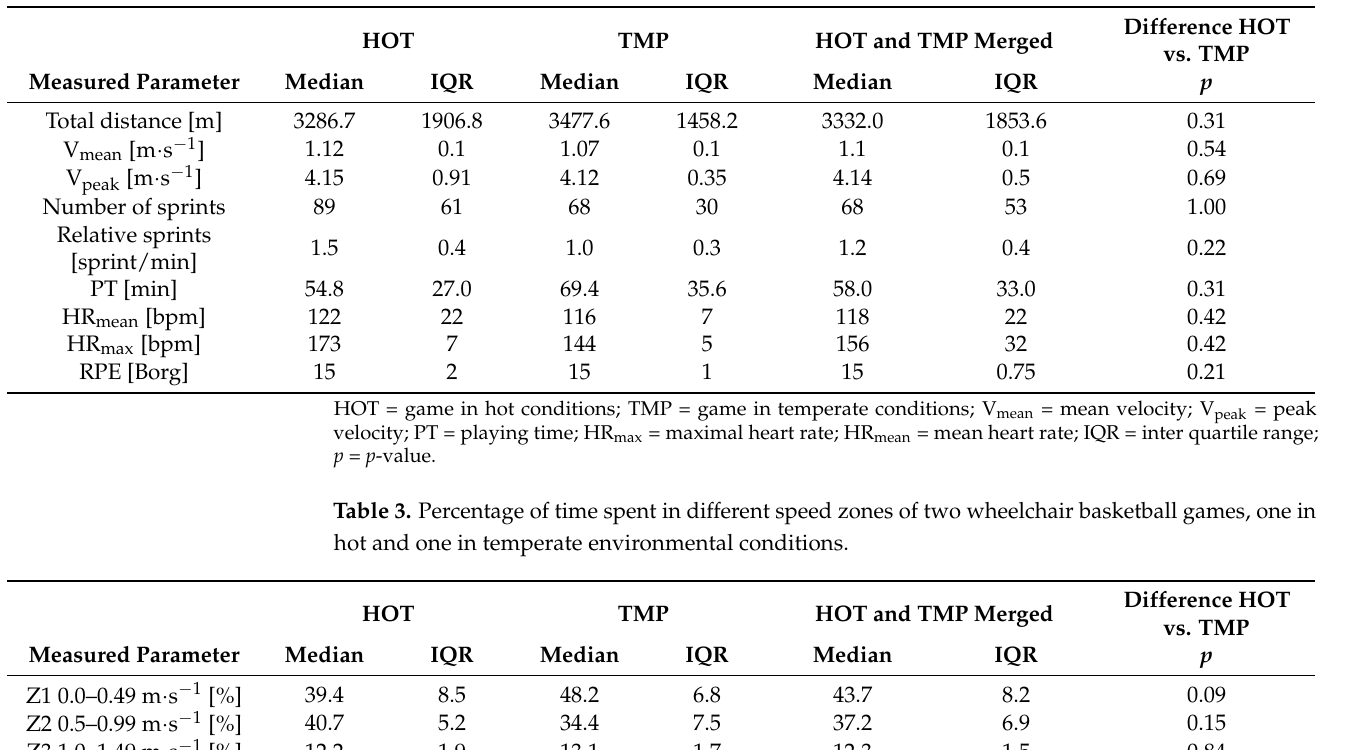
Table 2. Activity patterns of two wheelchair basketball games, one in hot and one in temperate environmental conditions.